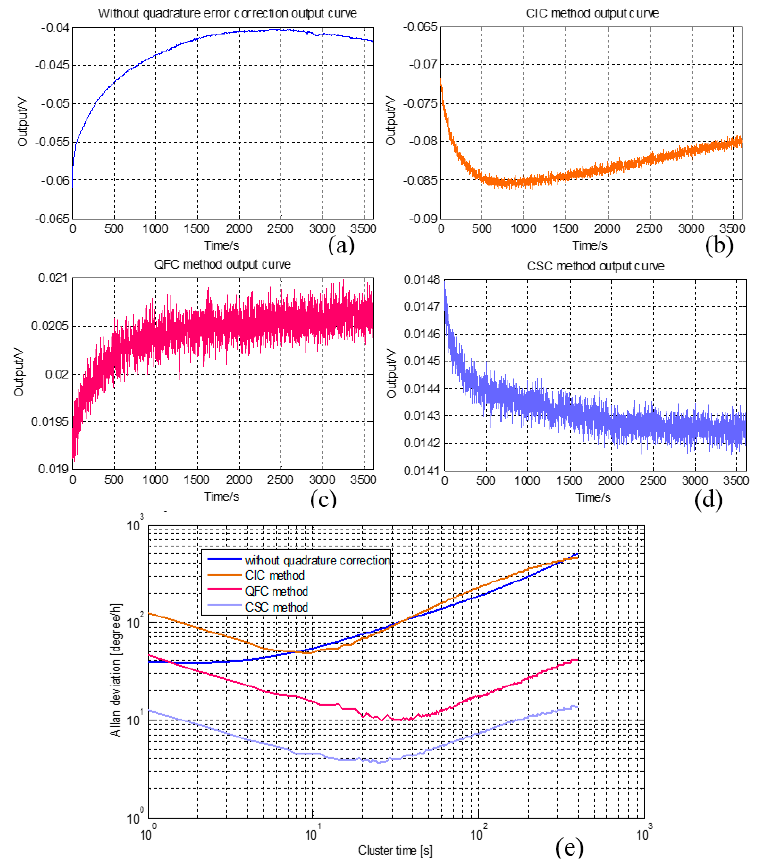
Figure 15. ( a ) Output signal without quadrature error; ( b ) Output signal with CIC system; ( c ) Output signal with QFC system; ( d ) Output signal with CSC system; ( e ) Allan deviation curves.